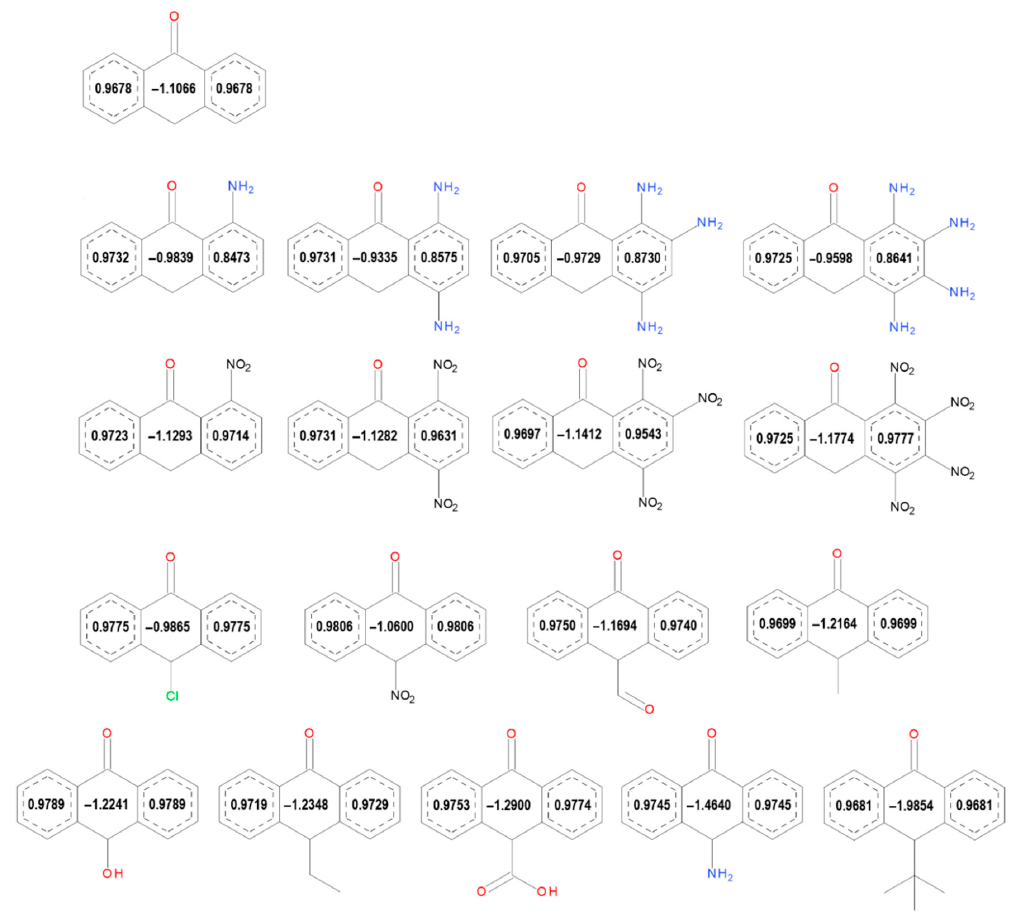
Figure 3. Harmonic oscillator model of aromaticity (HOMA) parameters for anthrone structures with a substituent in the side aromatic ring and in the central aliphatic ring.